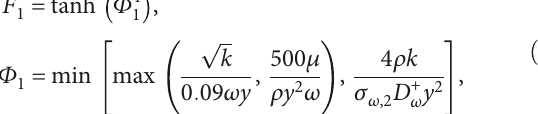
Table 3: Mass fractions of plume